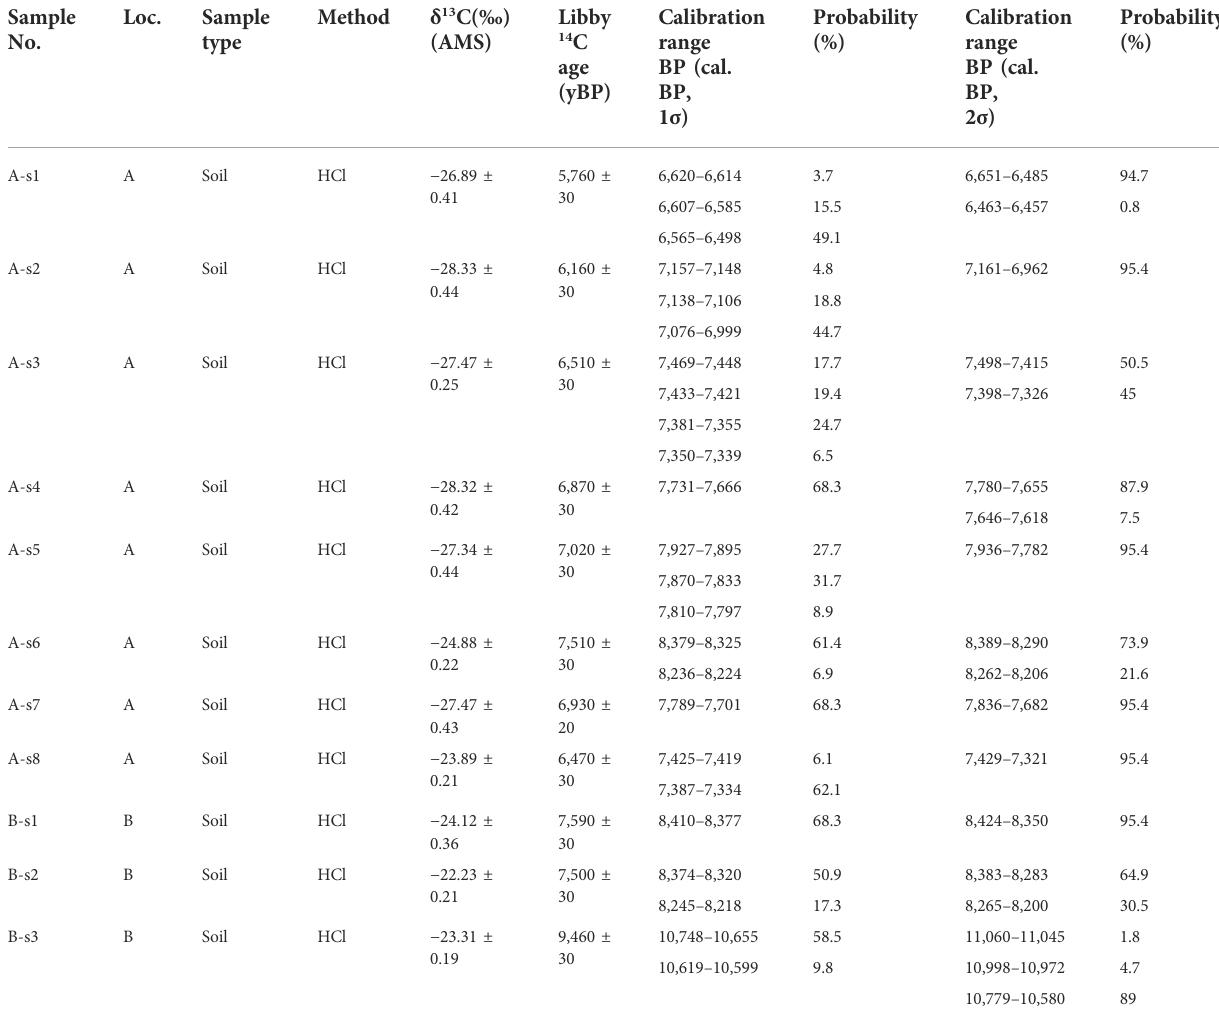
TABLE2Resultsofthe 14 CdatingofsoilscollectedfromLocalityAandBaroundUsuvolcanousingtheacceleratormassspectrometry(AMS)method. Sample